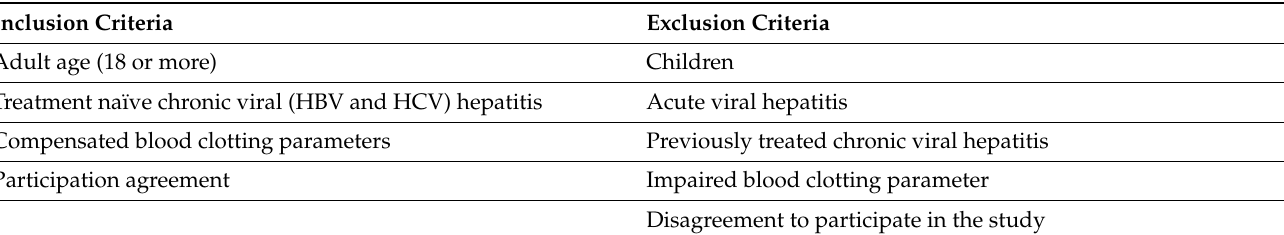
Table 1. Inclusion and exclusion criteria of the